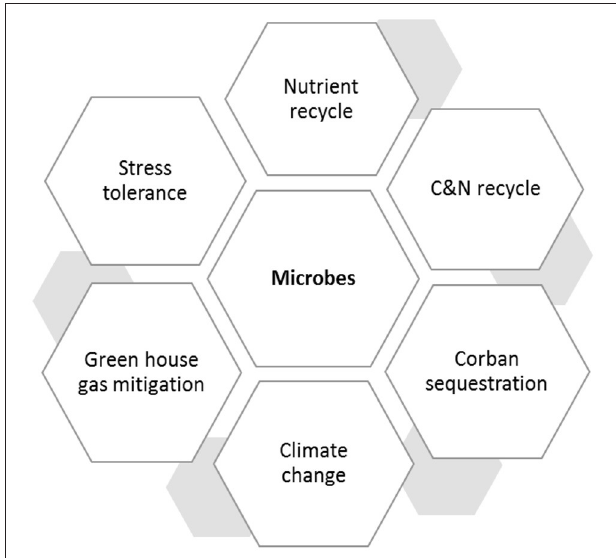
FIGURE 2 | Role of microbes in different aspects of climatic phenomena.